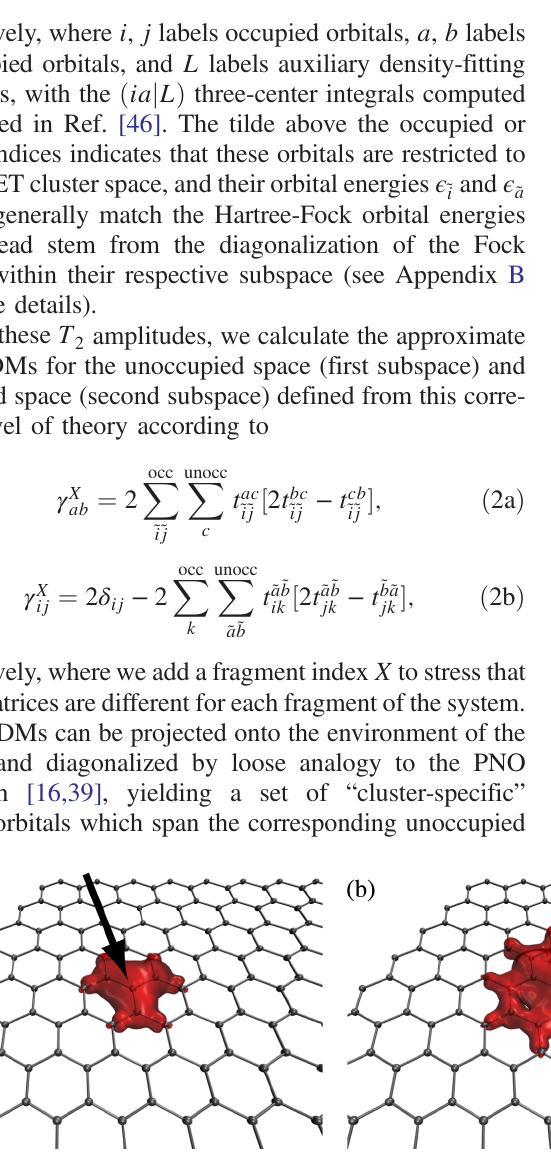
FIG. 1. Isosurface of the cluster orbital density in the embedding of a carbon atom [marked by the black arrow in (a)] in graphene. (a) – (c) The cluster grows in size as the bath orbital threshold η is reduced from 10 − 4 (a) to 10 − 6 (b) and 10 − 8 (c). An isovalue of 0.2 is used for all